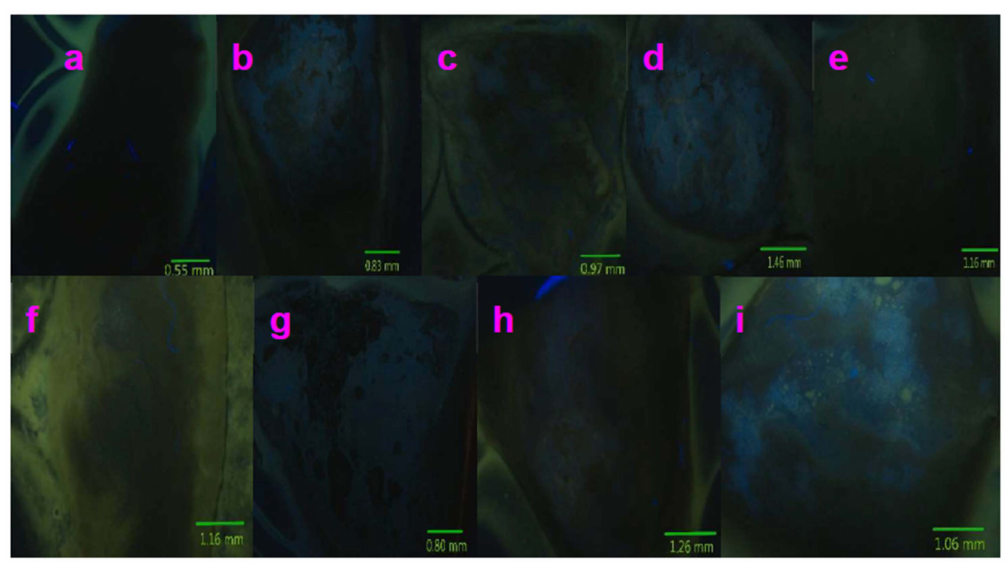
Figure 8. Fluorescence images of pig kidney coated with Sm–Me (Me = Fe, Ga, Mn, Na, Nb, W, Cu, and Al) nanoparticles are generated when UV-light excitation (359–371 nm) is used: ( a ) Control (no nanoparticles are used); ( b ) Sm–Fe; ( c )Sm–Ga; ( d ) Sm–Mn; ( e ) Sm–Na; ( f ) Sm–Nb; ( g ) Sm–W; ( h ) Sm–Cu; ( i ) Sm–Al.